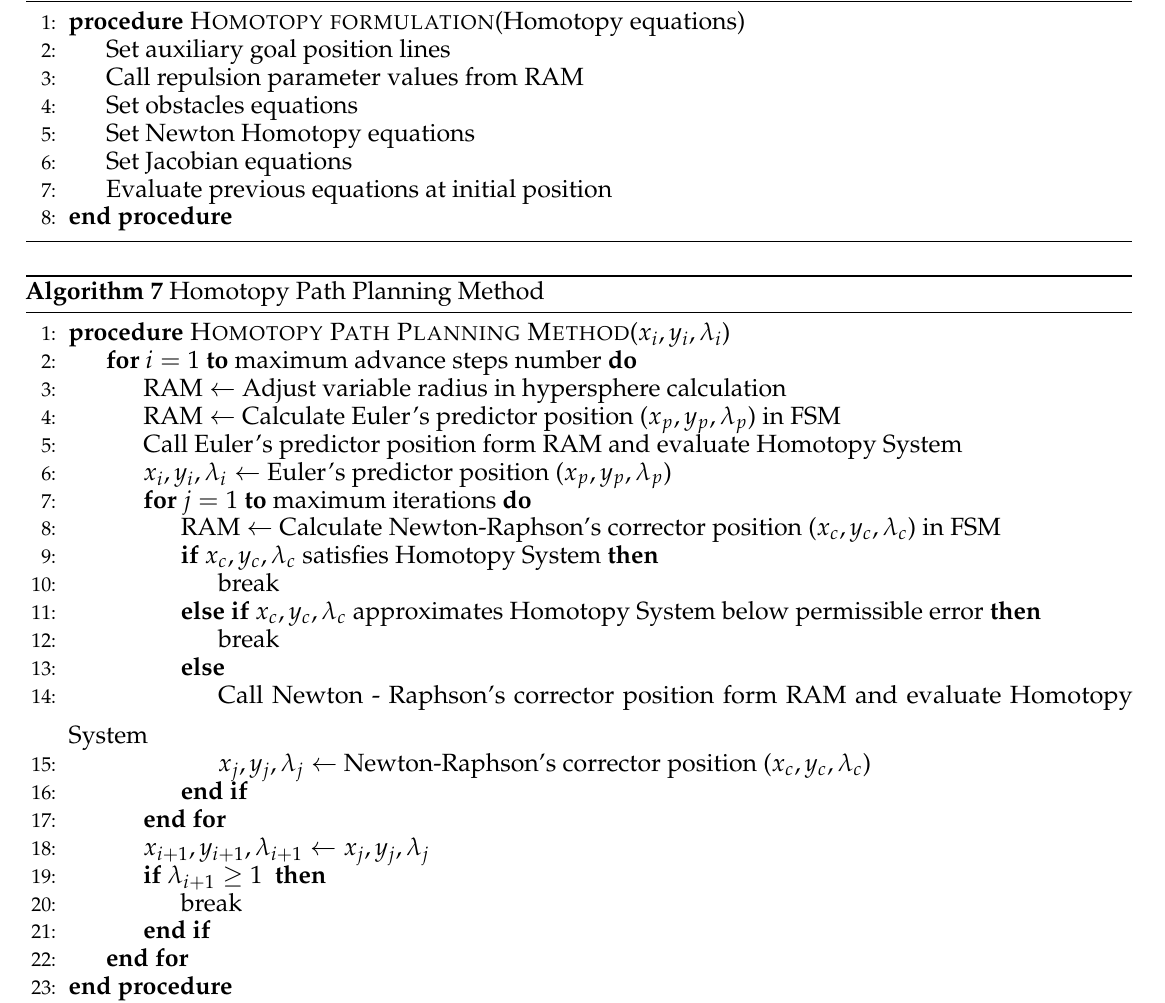
Algorithm 6 Homotopy formulation